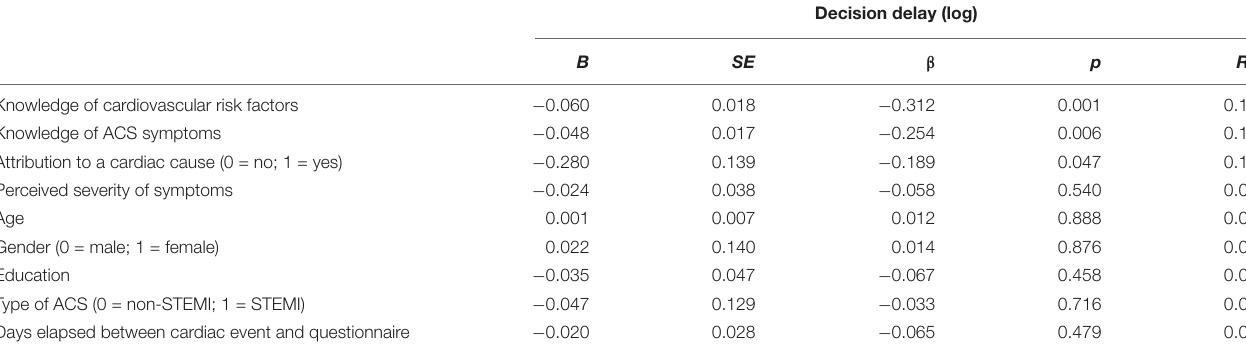
TABLE 5 | Linear regression analyses to determine the influence of each predictor on decision